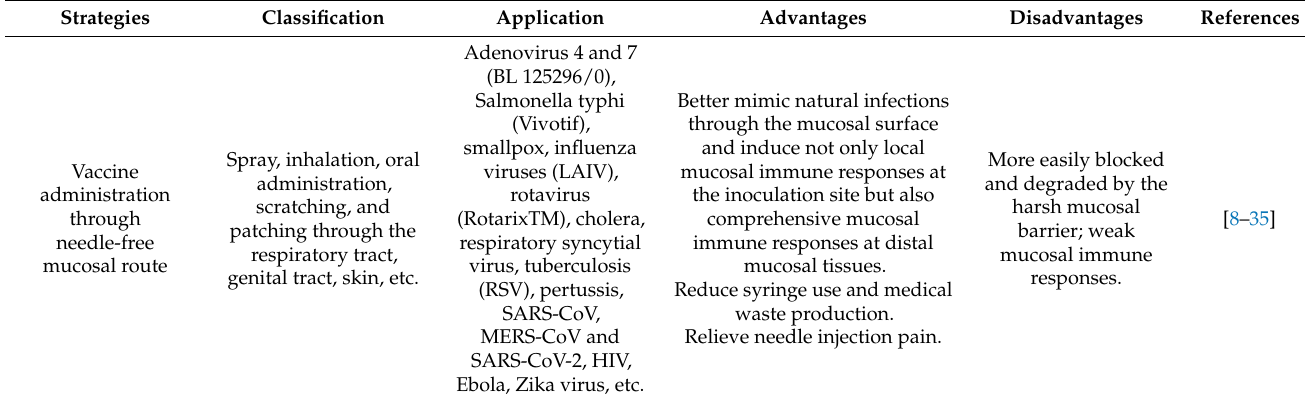
Table 1. Strategies with which to develop mucosa-targeting